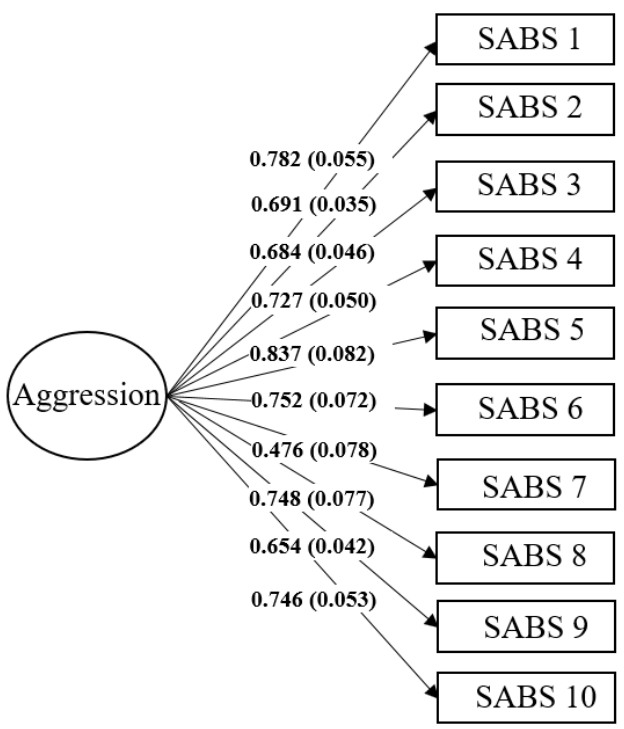
Figure 2. The single factorial structure of the Portuguese Version of SABS for CFA Female sample. Values represent standardized regression weights and standard error within brackets.